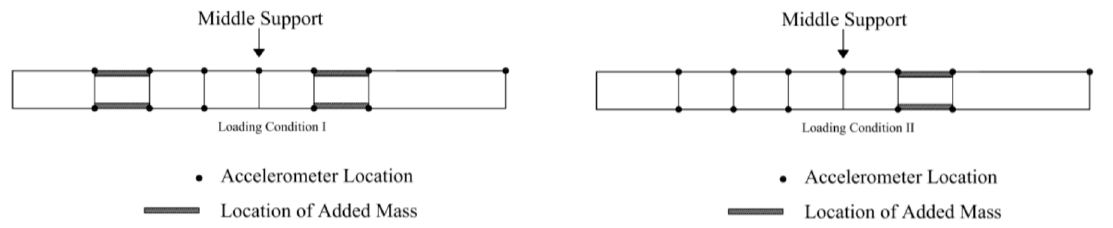
Figure 6. Loading scenarios I (left) and II (right) [54].